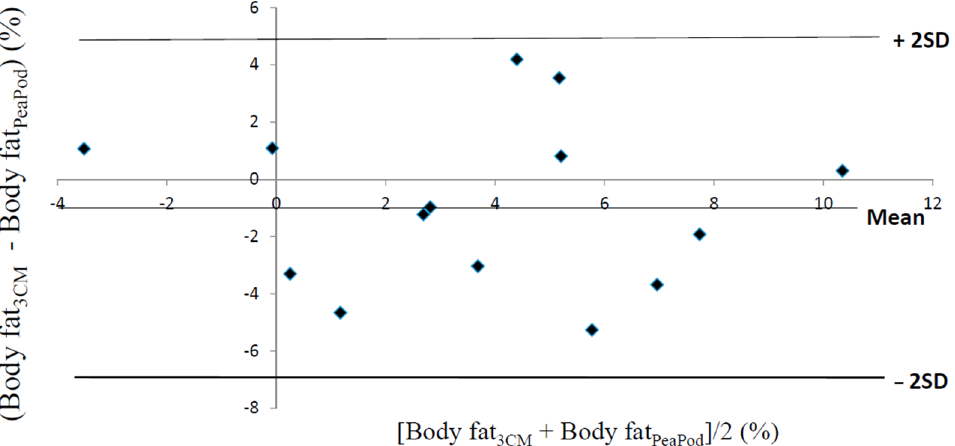
Figure 2. The difference between body fat, in % of body weight, assessed by means of the three ‐ component model (Body fat 3CM ) and the corresponding values assessed by means of the Pea Pod system (Body fat PeaPod ) (Body fat 3CM − Body fat PeaPod ) ( y ) versus the average of Body fat 3CM and Body fat PeaPod (Body fat 3CM + Body fat PeaPod )/2 ( x ). Average and ± 2SD (limits of agreement) for Body fat 3CM − Body fat PeaPod = − 1.00 ± 5.83%. Values are based on 14 moderately preterm infants, 3–7 days old.